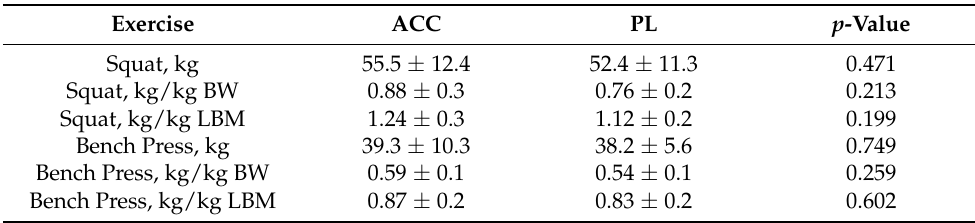
Figure 2. Mean ± SD post-pre 1-RM values ( ∆ 1-RM) for back squat 1-RM exercise (left graphs) and for bench press exercise (right graphs). Values are absolute kg (top graphs; normalized to body weight (BW) (middle graphs) and to lean body mass (LBM) (bottom graphs). * = significant between groups effect ( p < 0.05). using a linear regression model (see statistical analysis); ACC = ACC group, PL = placebo group. Table 4. Mean ± SD baseline 1-RM values performed by the ACC ( n = 14) and the PL ( n = 17) groups (two-tailed t